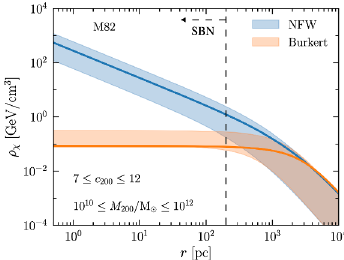
Figure 3. DM energy density as a function of r . The Blue band corresponds to the NFW profile, while the orange one corre- sponds to the Burkert profile. The vertical line correspond to the dimension R of a typical starburst nucleus R =